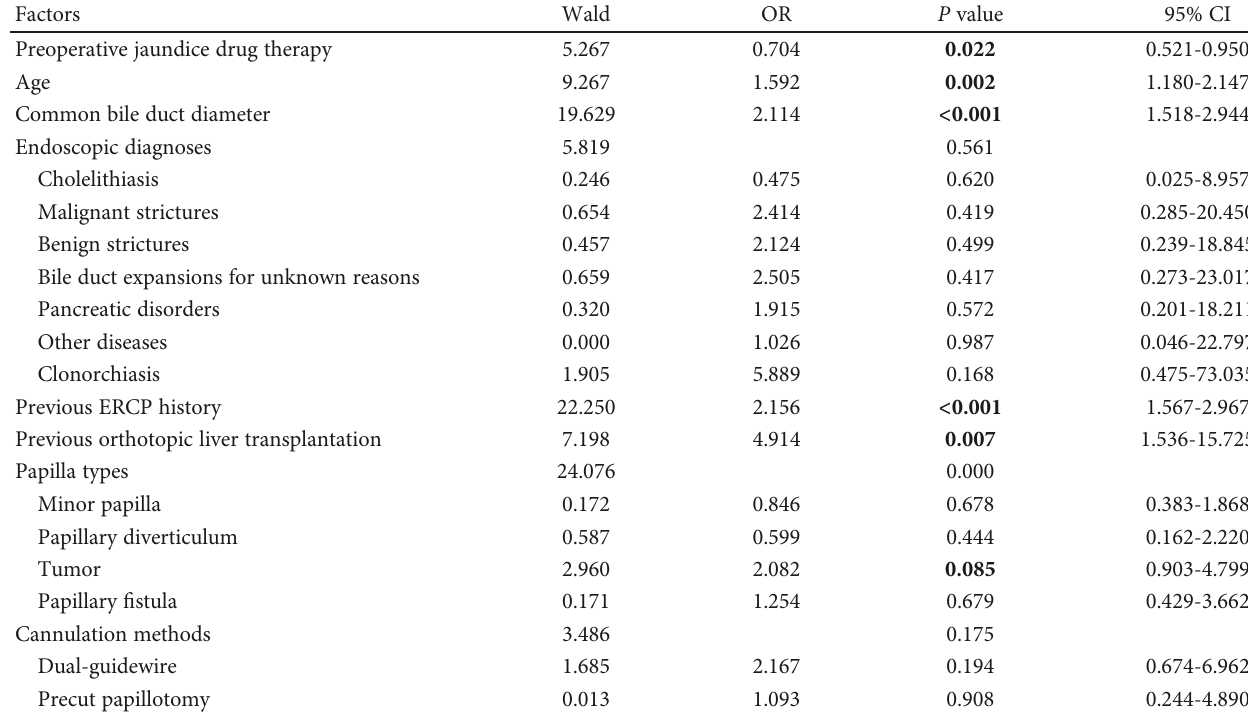
Table 5: Multivariate analysis of risk factors for positive bile